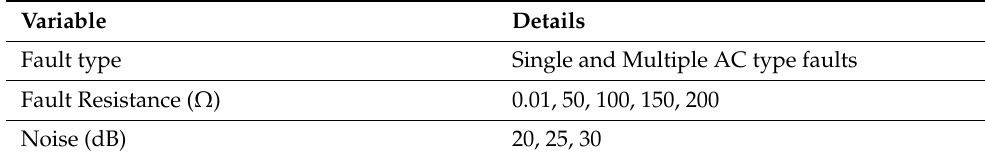
Table 2. Case studies for external faults in training Table 1. Case studies for internal faults in training data .